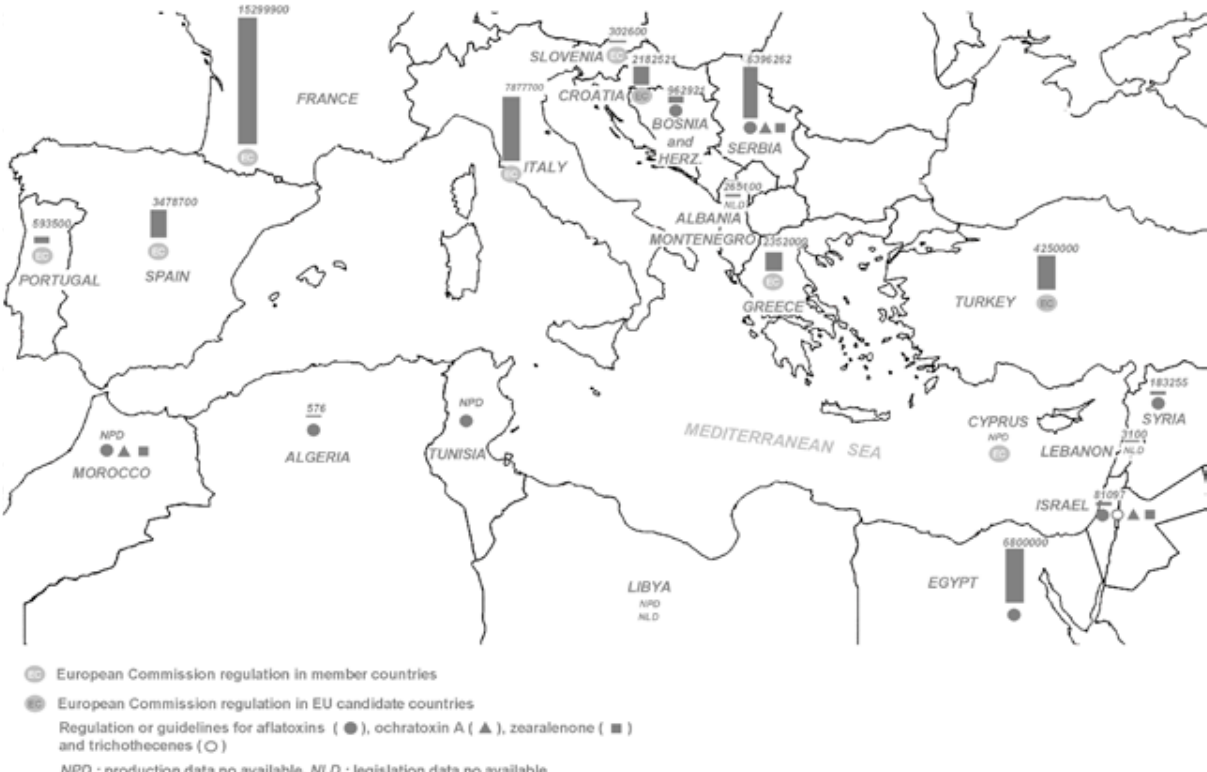
Figure 1. Production of maize and legislation of mycotoxins in maize in Mediterranean countries [Production in tones dur- ing 2009 (FAOSTAT,